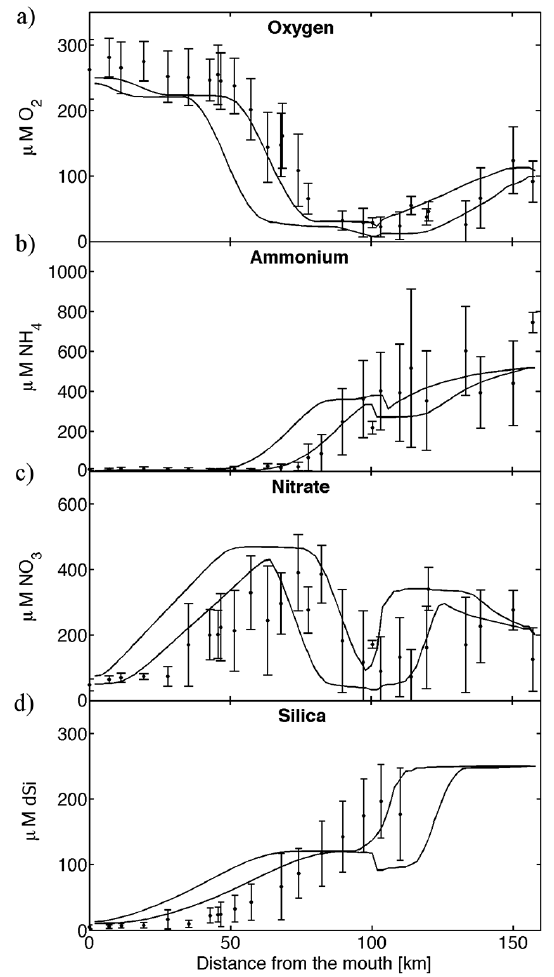
Figure 10. Comparison between longitudinal distributions of field data averaged over the period May–September for the years 1990– 1995 (dots; vertical bars correspond to the standard deviation) and steady-state maximum and minimum O 2 , NH 4 , NO 3 and dSi con- centrations over a tidal cycle (solid line). Physical conditions are summarized in Table 2, boundary conditions and external forcings are summarized in Table 3 and parameters are listed in Tables 4